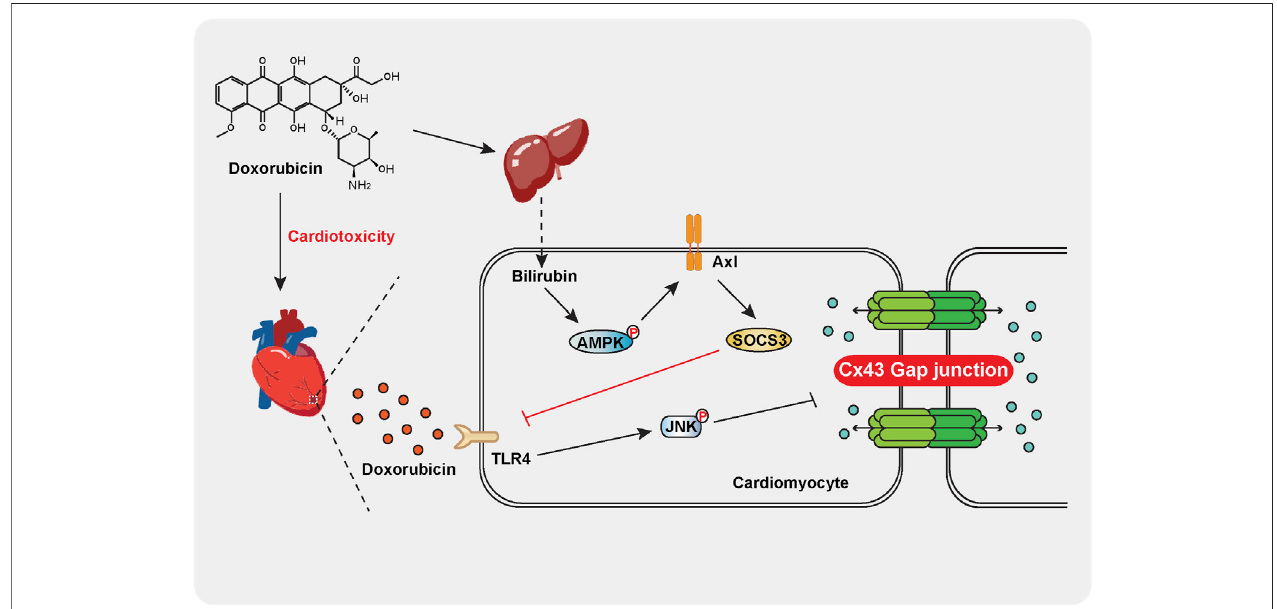
FIGURE 7 | Schematic indicating that moderate increase bilirubin can inhibit doxorubicin-induced gap junction ’ dysfunction and conduction abnormalities via regulatingAMPK-Axl-SOCS3signalingaxis.Doxorubicinsigni fi cantlyincreasesthephosphorylationofJNKandCx43inmousecardiomyocytes,leadingtogapjunction ’ dysfunction and conduction abnormalities and causing cardiotoxicity. Bilirubin induces SOCS3 expression in an AMPK-Axl-dependent manner, inhibiting JNK-Cx43 signaling pathway to improve gap junction ’ function and conduction abnormalities.